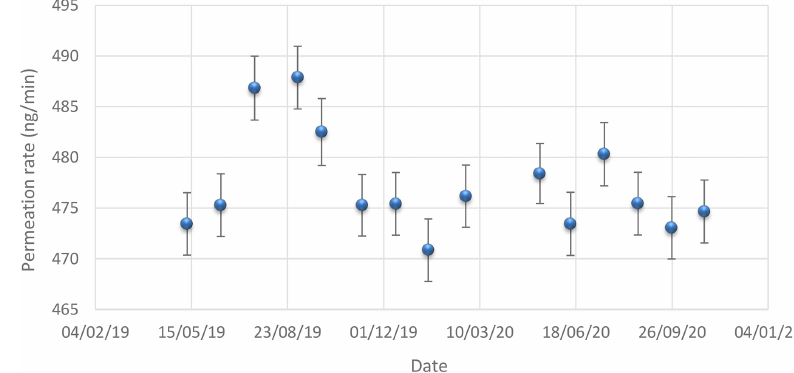
Figure 4. Evolution of the permeation rate of the tube over time. The points represent the different values of the permeation rate measured over time. The error bars correspond to the expanded uncertainty ( k = 2) on the determination of the tube permeation rate. Table 1. The uncertainty budget of one of the permeation rates used in this study. The contribution, in percent, of each variable to the overall uncertainty is indicated in the weight column. The last row shows the permeation rate value and its expanded uncertainty. k is the coverage factor of the